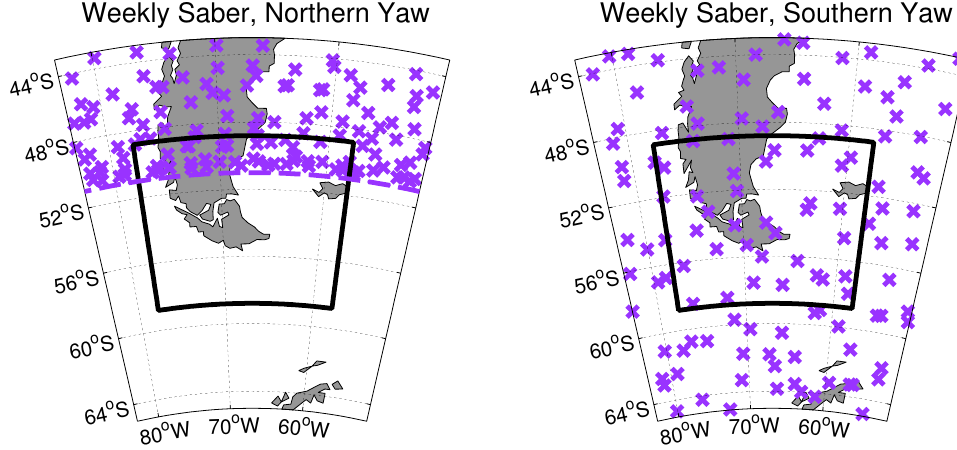
Figure 7. Typical weekly coverage for SABER during the northern (left) and southern (right) phase of the instrument yaw cycle. The dashed line in left panel indicates the approximate poleward limit of observations in this yaw phase. Note the greater observation density in the covered part of our region during the northern phase of the yaw cycle, due to the scan track turnaround near these latitudes. Specific coverage illustrated is from 1–7 March 2006 (left) and 1–7 January 2006 (right).